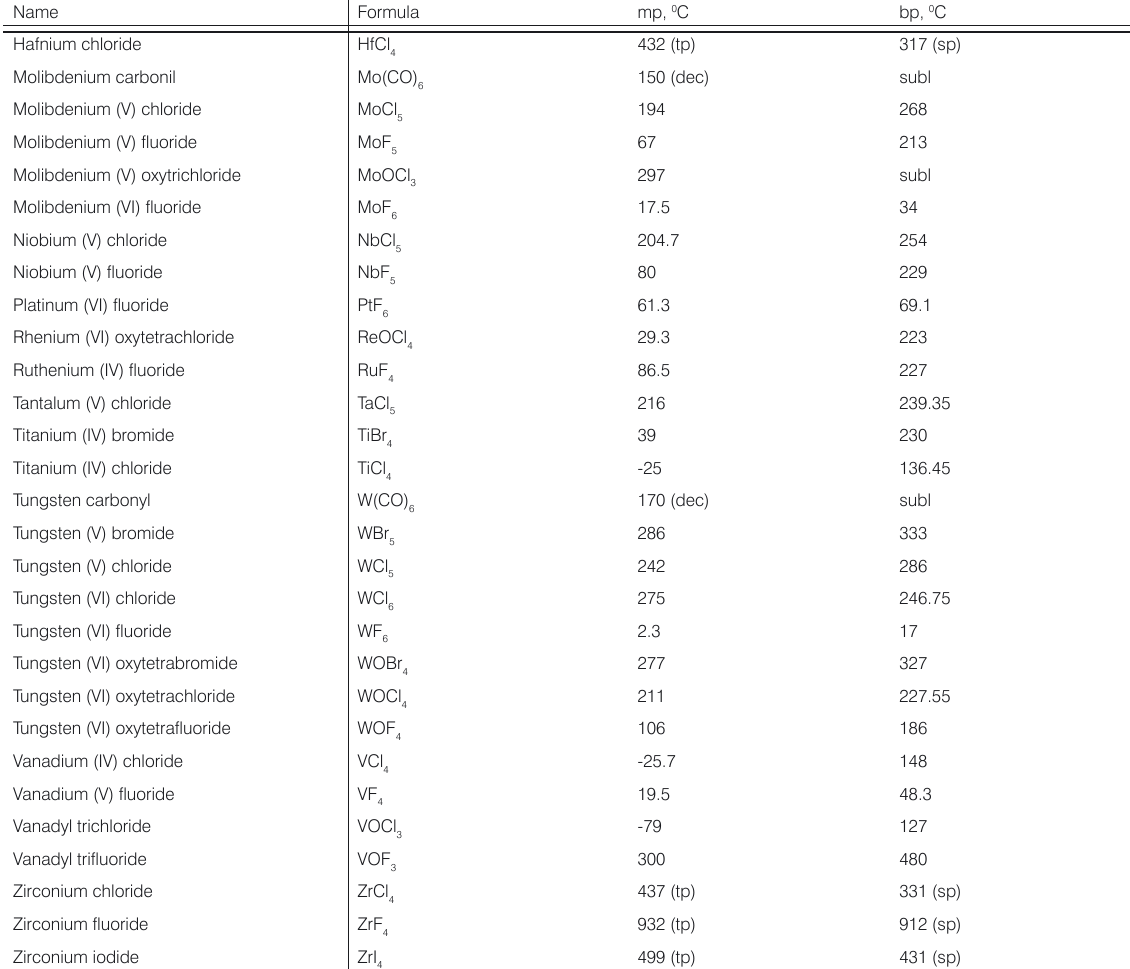
Table 1. Various metal precursors suitable for the synthesis of the IF nanoparticles and nanotubes by the gas phase reaction (including those that have been used to synthesize the IF nanoparticles and nanotubes mentioned in this